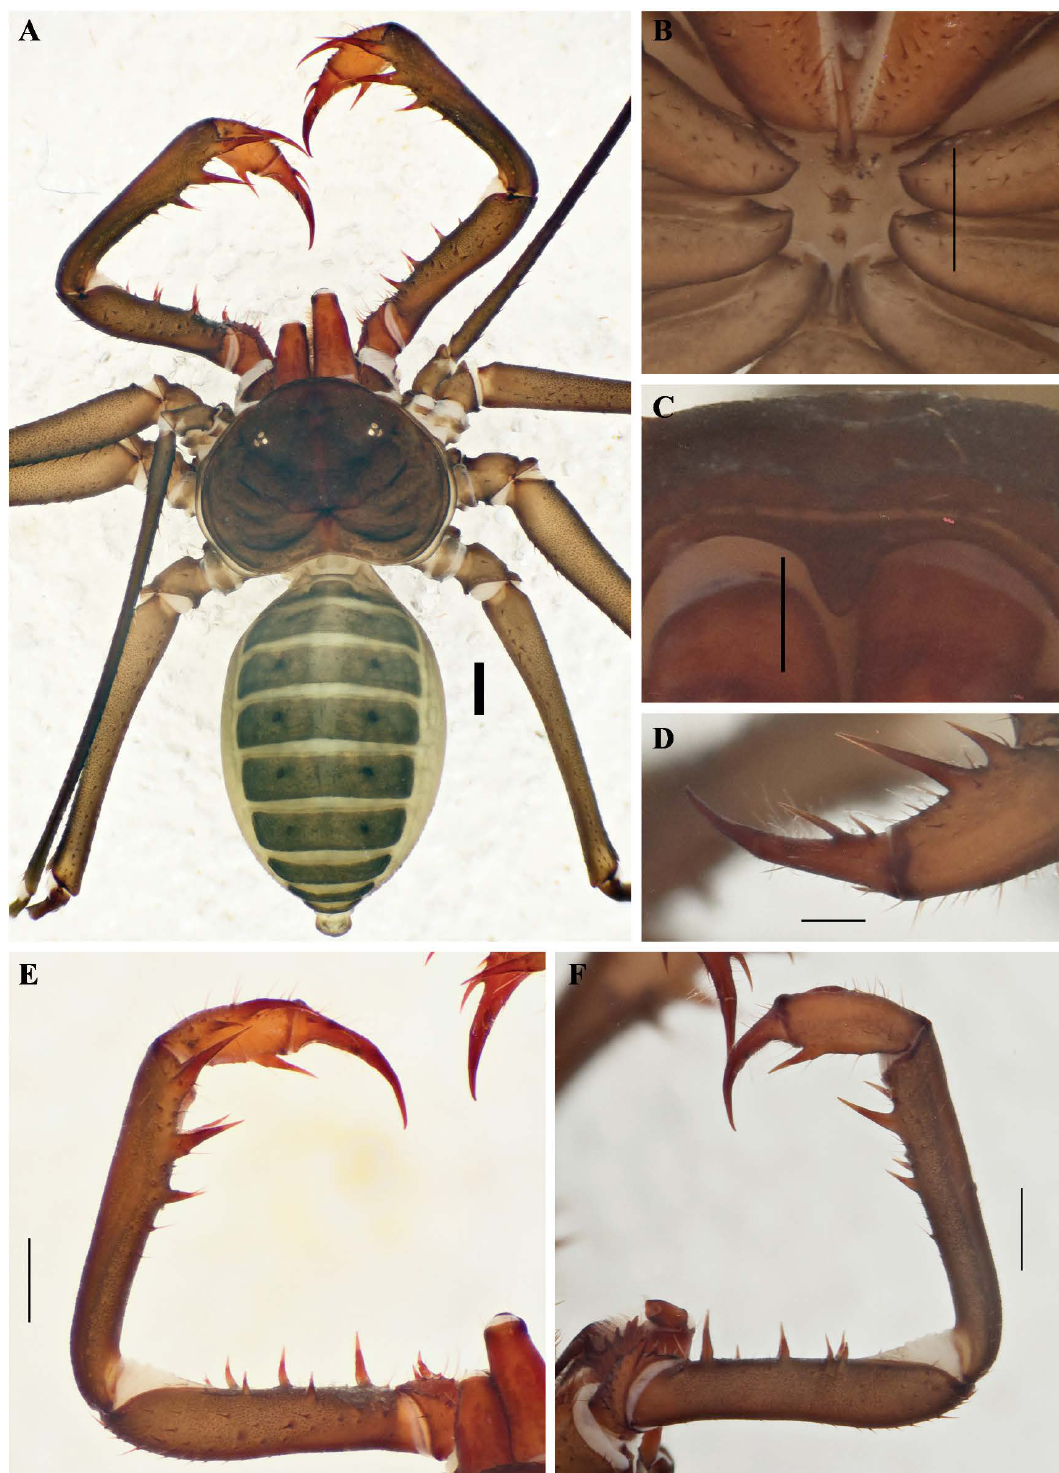
Fig. 32. Charinus perquerens sp. nov. (MNRJ 9283), general morphology, ♀. A . Habitus, dorsal view. B . Sternum, ventral view. C . Frontal process. D . Pedipalp tarsus, frontal view. E . Pedipalp, dorsal view. F . Pedipalp, ventral view. Scale bars: A–B, E–F = 1 mm; C–D = 0.5 mm.